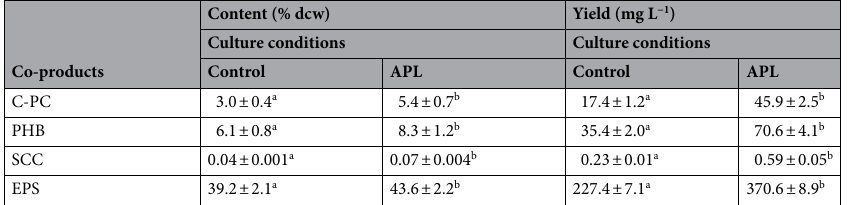
Table 8. Co-products obtained individually from A. variabilis grown in the BG-11 control and APL medium, expressed as content (% dcw) and yield (mg L −1 ). Values were calculated as the mean (± SE) of three independent observations, i.e., n = 3. Significant differences among the values (P < 0.05, DMRT) within a row are designated using different alphabetic annotations. Each row was analyzed separately for content and